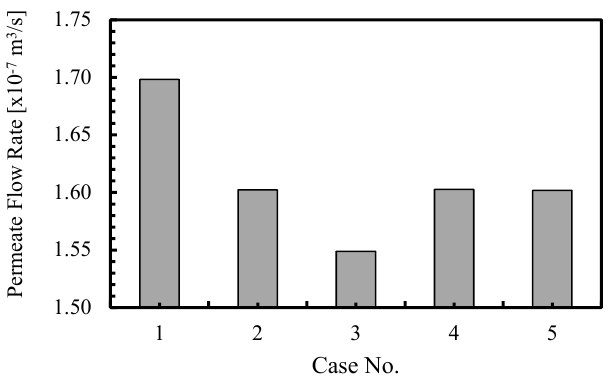
Figure 4. Comparison of flow rate at permeate outlet, of all 5 test cases with different element counts used in GIT.